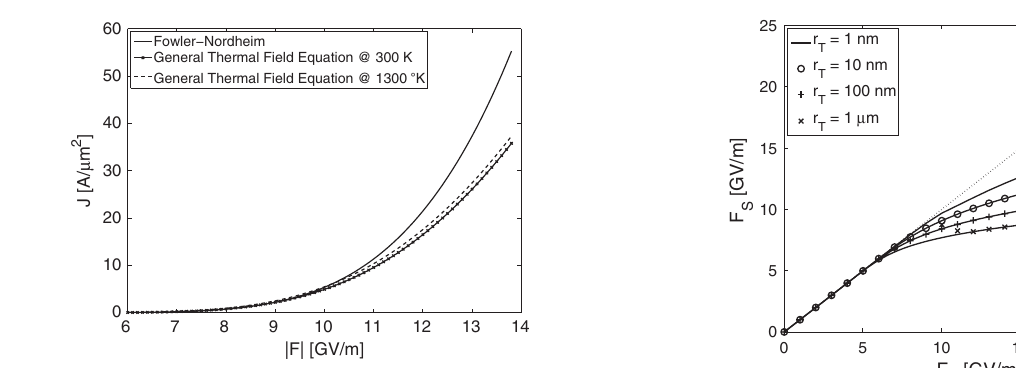
FIG. 4. Electric field magnitude in the presence of space charge effect F S compared to its vacuum value F V for various values of tip radius r T . Tip radius is the radial distance, measured from the vertical axis, of the point on the surface of the protrusion, at which the emission current drops to its half- maximum value. The distance r T is approximately equal to the radius of curvature of the tip. The dotted line shows the case with no space charge. F S cannot exceed 14 GV = m , the maximum electric field that Eq. (2) allows.